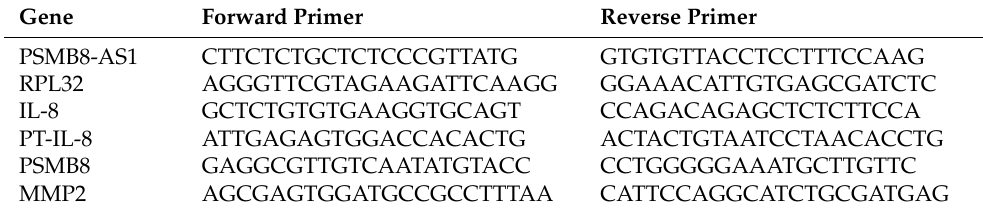
Table 3. Gene specific primer pairs used for